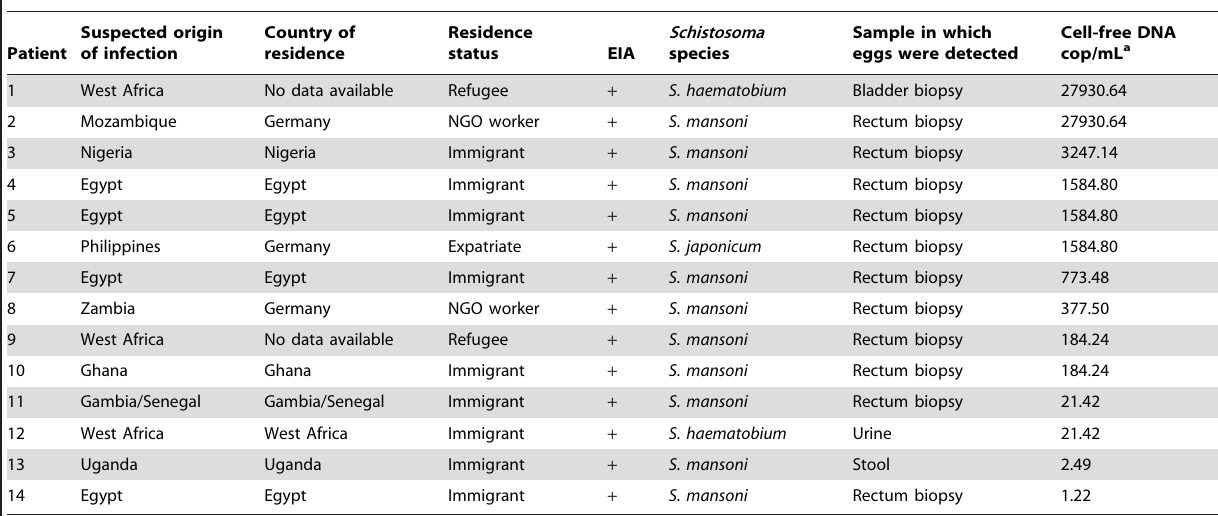
Table 1. Patients with chronic